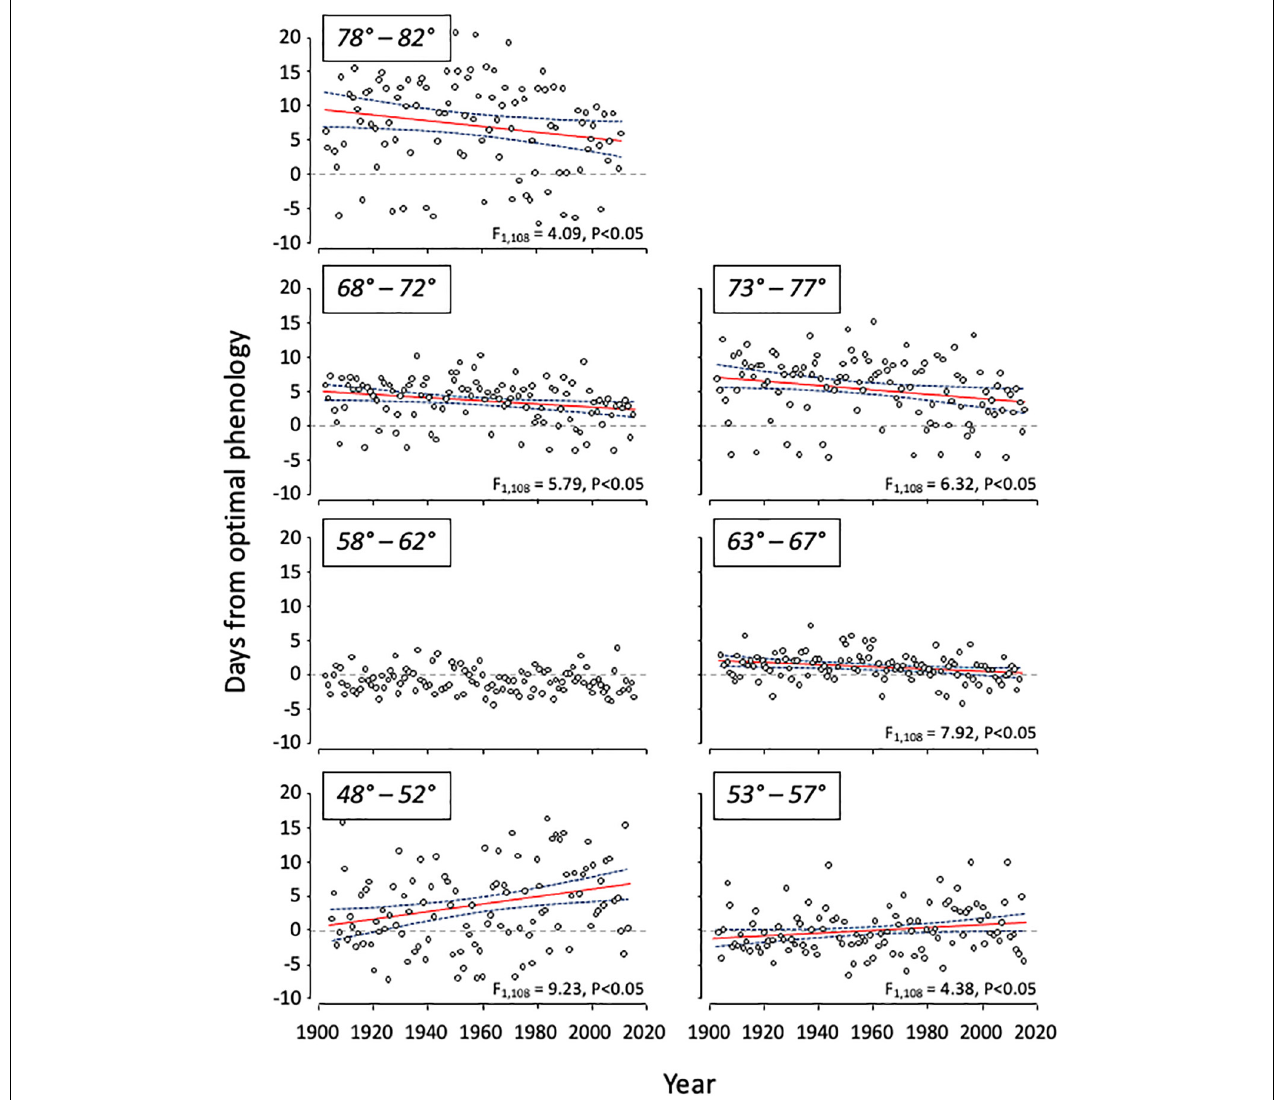
FIGURE 3 | Linear regressions, with 95% confidence intervals, of deviation from optimal phenology (i.e., predicted difference between dates of Douglas-fir budburst and larval emergence) versus year for the western spruce budworm in British Columbia, Canada. Data were binned into equal intervals of 5 ◦ effective latitude, and annual averages were calculated within bins, with sample size of 108 in each